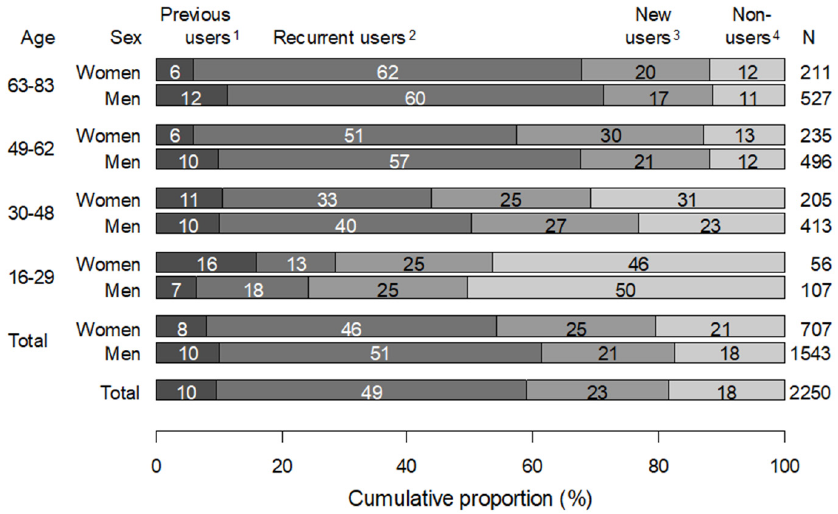
Figure 1. Proportion (%) of patients with statins dispensed one year (1–365 days) after and/or one year (364–0 days) before the first kidney transplant (Tx) in total and according to sex and age group. The number of KTRs is given in the right margin. 1 Use before but no use after Tx; 2 Use both before and after Tx; 3 No use before but use after Tx; 4 No use before or after Tx.